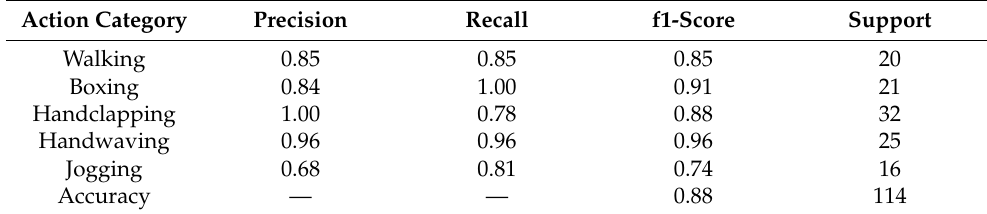
Table 3. Classification results for SC + SRN using KNN-DTW with KTH-5. Action